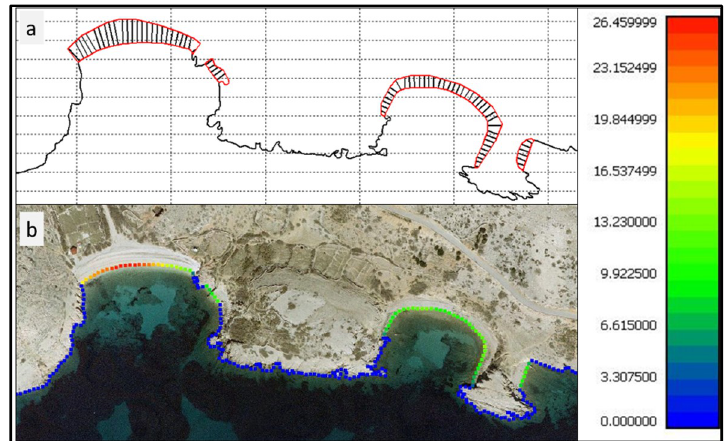
Figure 5. Analysis of the beach width parameter: ( a ) Defined beach polygons with corresponding beach width; ( b ) The calculated cross-shore beach width every 5 m.